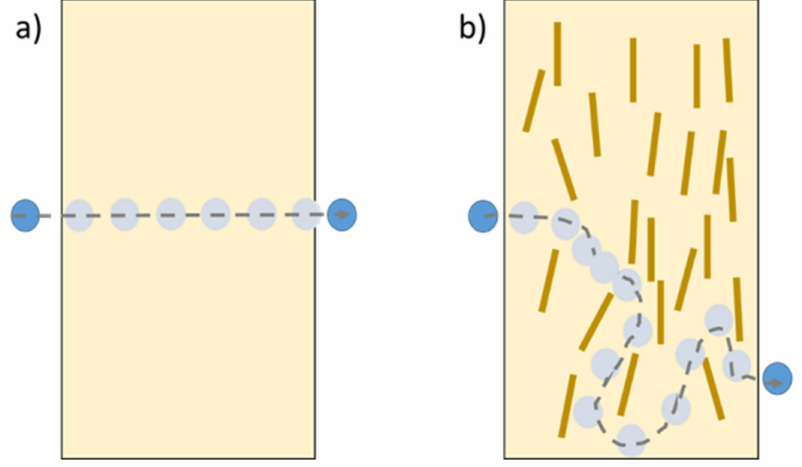
Figure 9. Schematic representation of molecular diffusion through ( a ) TPS and ( b ) TPS nanocomposite.